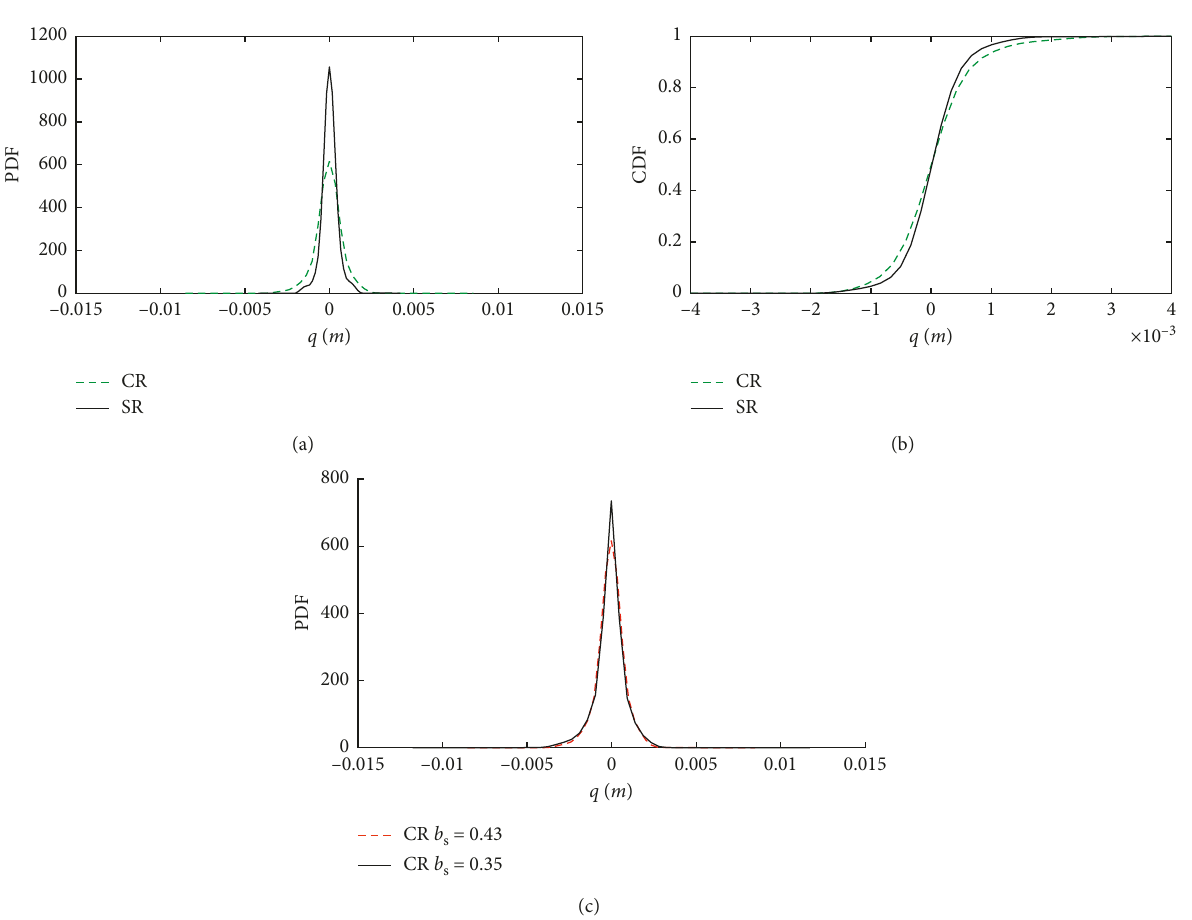
Figure 7: Influence of randomness under N p (cid:31) 120. (a) Comparative PDF results of the CR and SR cases. (b) Comparative CDF results of the CR and SR cases. (c) Comparative PDF results of different b s (under CR case).